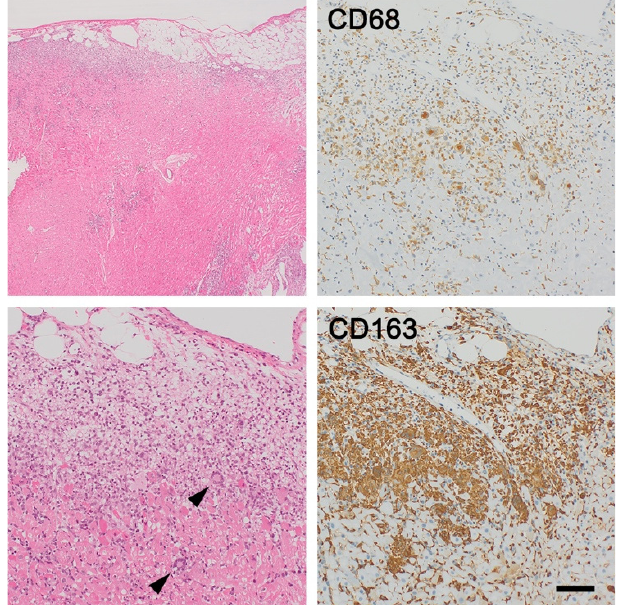
Figure 5. Giant cell myocarditis. Giant cell myocarditis and cardiac sarcoidosis are sometimes notably difficult to distinguish. In this case, subepicardial predominance is unusual for cardiac sarcoidosis, and not only macrophage accumulation but also lots of lymphocyte and eosinophil infiltrations are compatible with giant cell myocarditis. Immunohistochemistry is also valuable for pathological diagnosis; the number of CD68 + CD163 + M2 macrophages accumulated is greater compared with that of CD68 + CD163 − M1 macrophages, suggesting giant cell myocarditis rather than cardiac sarcoidosis. Bar = 500 μ m for a lower magnification field, 100 μ m for higher magnification fields.